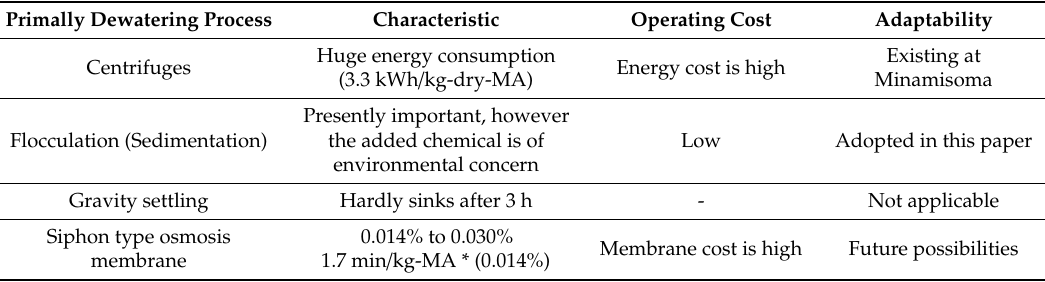
Table 2. Evaluation of di ff erent methods in the primary dewatering process of microalgae production at Minamisoma